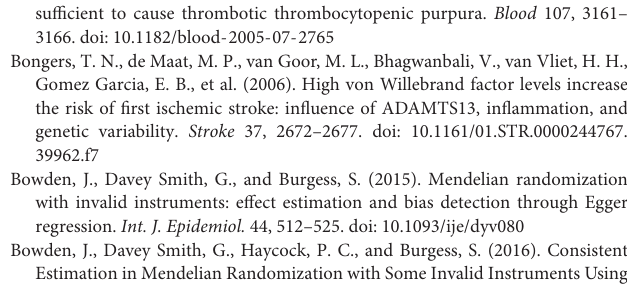
Supplementary Figure 1 | Funnel plot visualizing the horizontal pleiotropy of SNPs related to ADAMTS13 level. (A) Coronary heart disease, (B) myocardial infarction, (C) atrial fibrillation, (D) heart failure, and (E) venous thromboembolism. Supplementary Figure 2 | Funnel plot visualizing the horizontal pleiotropy of SNPs related to ADAMTS13 activity. (A) Coronary heart disease, (B) myocardial infarction, (C) atrial fibrillation, (D) heart failure, (E) ischemic stroke, and (F) venous thromboembolism. Supplementary Figure 3 | Comparison of different statistical methods for MR analysis to assess the causality between ADAMTS13 level and cardiovascular diseases. ADAMTS13 level has a causally negative correlation with coronary heart disease (A) , myocardial infarction (B) , heart failure (D) , and venous thromboembolism (E) , ADAMTS13 has a positive causal association with atrial fibrillation (C) . Supplementary Figure 4 | Comparison of different statistical methods for MR analysis to assess causality between ADAMTS13 activity and cardiovascular diseases. ADAMTS13 activity has a causally negative correlation with coronary heart disease (A) and myocardial infarction (B) . No correlation was observed between ADAMTS13 activity and atrial fibrillation (C) , heart failure (D) , ischemic stroke (E) , and venous thromboembolism (F) . Supplementary Figure 5 | Single SNP analysis of ADAMTS13 level. Supplementary Figure 6 | Single SNP analysis of ADAMTS13 activity. Supplementary Figure 7 | Leave-one-out analysis of ADAMTS13 activity. (A) Coronary heart disease, (B) myocardial infarction, (C) atrial fibrillation, (D) heart failure, (E) ischemic stroke, and (F) venous